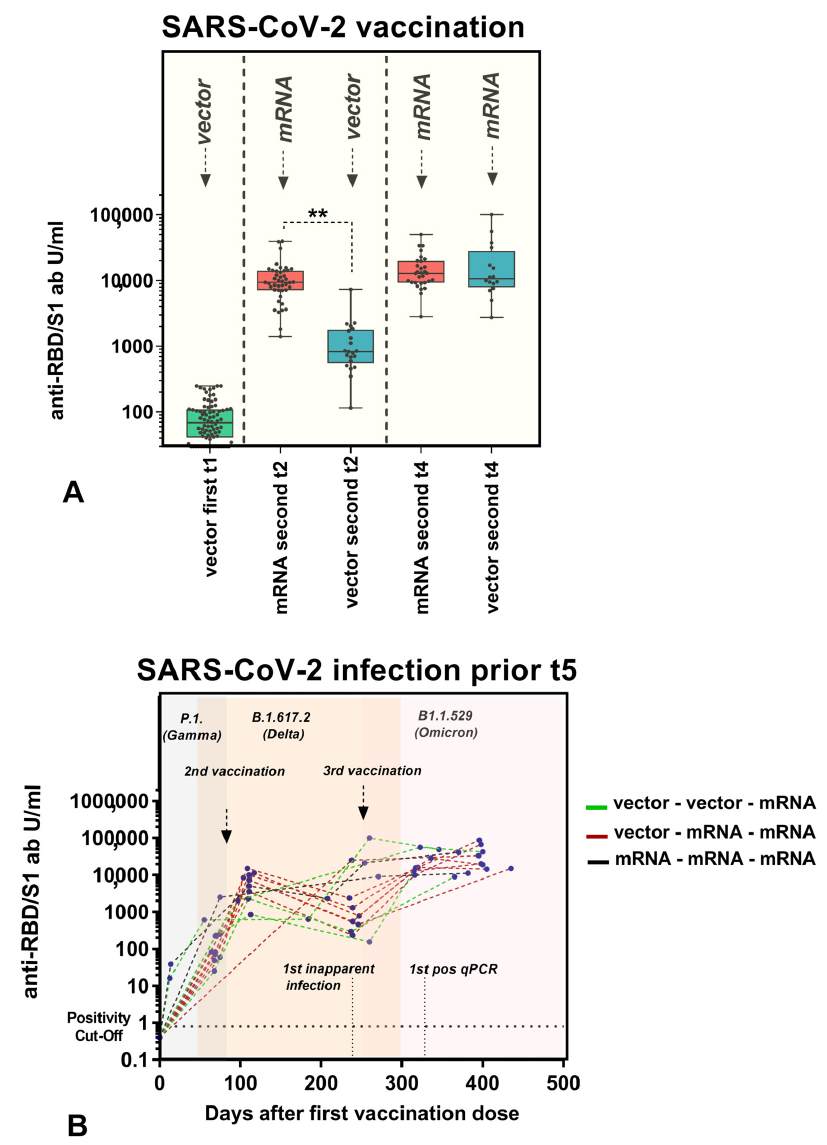
Figure 5. ( A ) Influence of vaccination strategy on antibody production. Dot plots illustrating anti- RBD/S1 antibodies (U/mL; x-axis) related to the vaccination schedule. All participants received ChAdOx1 nCoV-19 as the first vaccination. The homologous cohort received vector-based ChAdOx1 nCoV-19, and the heterologous cohort received mRNA-based NT162b2 as the second dose. This was reversed with the third vaccination, as all participants were vaccinated with NT162b2 or mRNA-1273. Antibody titers were compared between cohorts after the second and third vaccinations by the Kruskal–Wallis rank sum test. p -values 0.05 were considered to be significant; ** p -values < 0.001. ( B ) Individual anti-RBD/S1 Ig titer (U/mL; y -axis) related to days after the first vaccination (days; x - axis). The variants circulating in the respective period with a chronological overlap are highlighted in color (gray = P1. (Gamma), apricot = B.1.617.2 (Delta), light pink = B1.1.529 (Omicron)). Approxima- tion of second/third vaccination, first inapparent infection and first positive qPCR result is illustrated. Vector–vector–mRNA cohort: green, vector–mRNA–mRNA cohort: red, mRNA –mRNA–mRNA: black (individual cases). Most of the subjects experienced a breakthrough after the observation period (t 5